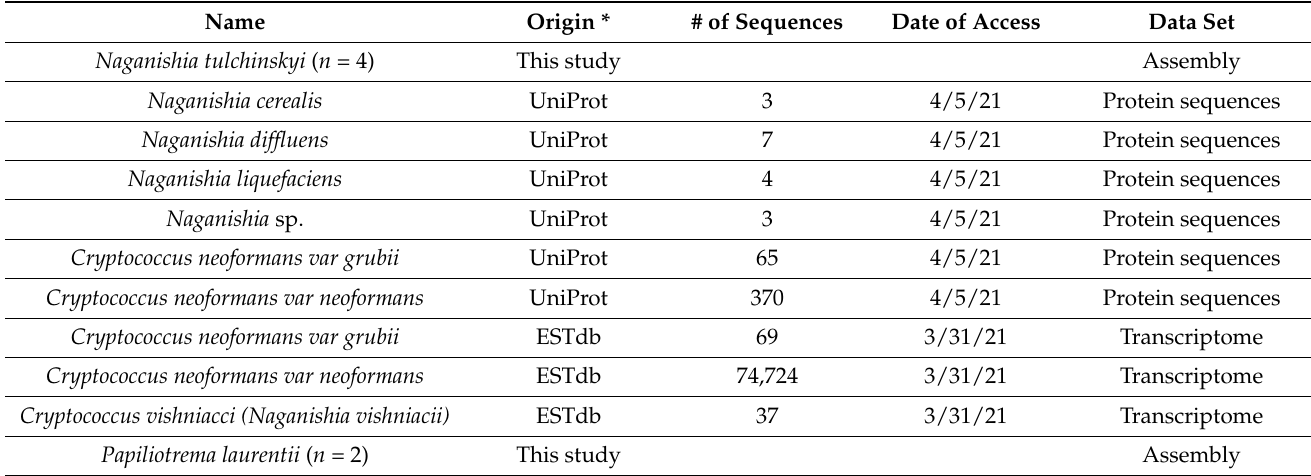
Table 2. Datasets used for De Novo gene annotation using